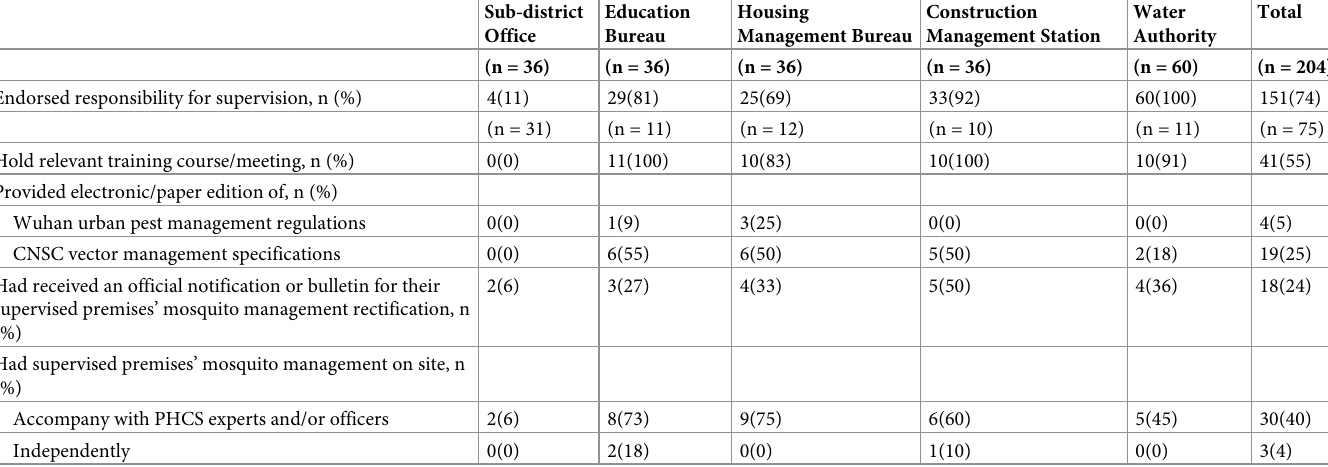
Table 3. Guidance and supervision of district responsible departments surrounding NSC mosquito management of built-up areas of